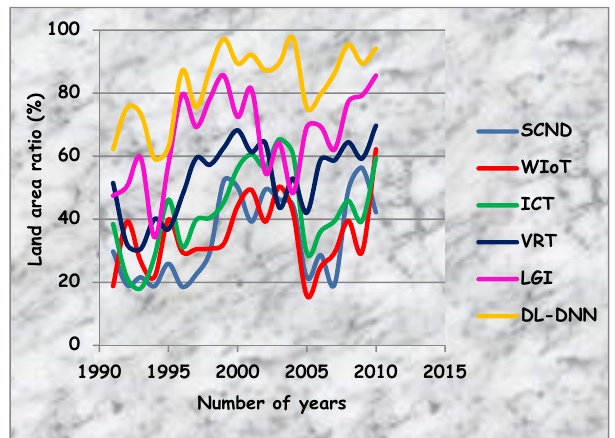
Figure 11: Administration of land - use changes.